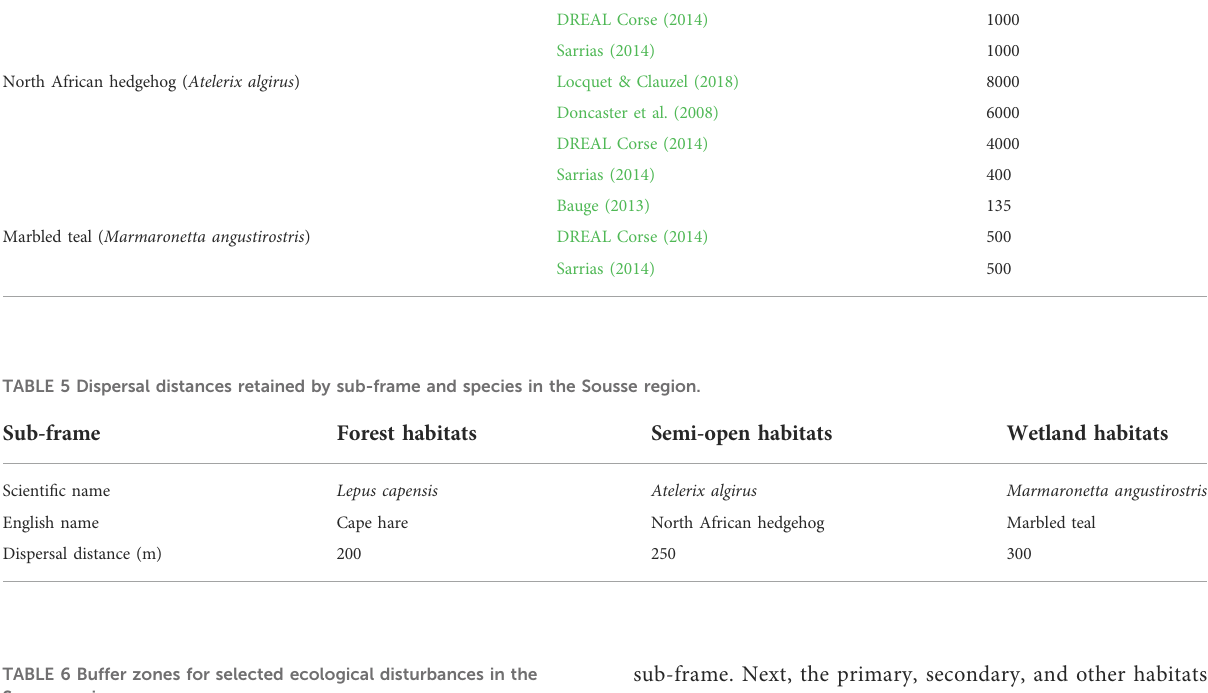
TABLE 6 Buffer zones for selected ecological disturbances in the Sousse region. Anthropogenic elements